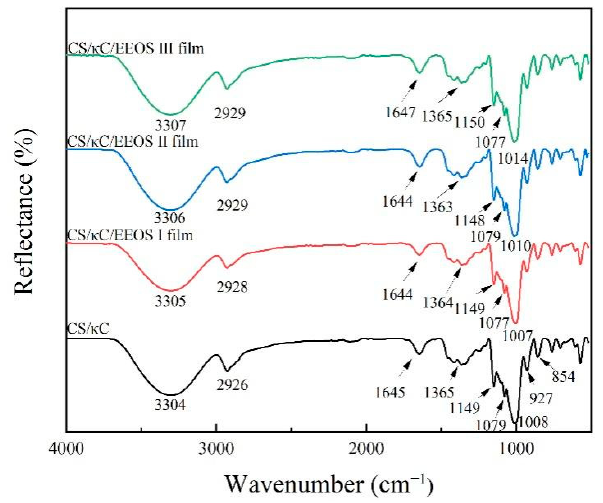
Figure 1. FTIR spectra of CS/ к C, CS/ к C/EEOS I, CS/ к C/EEOS II, and CS/ к C/EEOS III composite films.